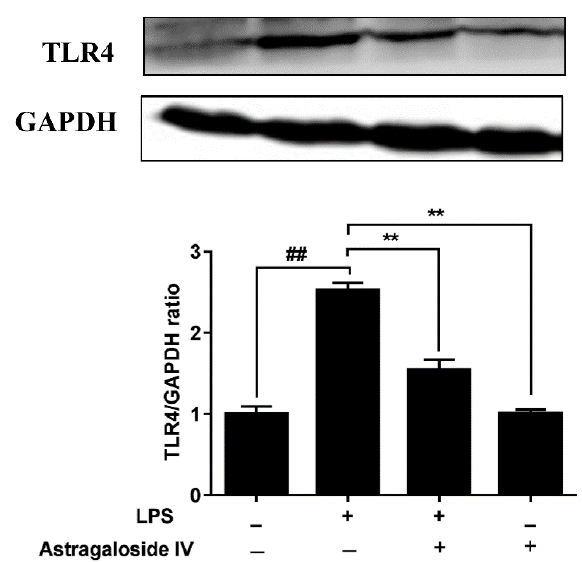
Figure 7. Effects of AS IV on LPS-induced TLR4 protein expression in uteri. Protein levels were detected by Western blotting. Relative protein levels were analyzed by grey scanning. The data are shown as mean ± SD, n = 3; **, p < 0.01. ## indicates a significant difference from the LPS − /AS IV − group ( p < 0.01).